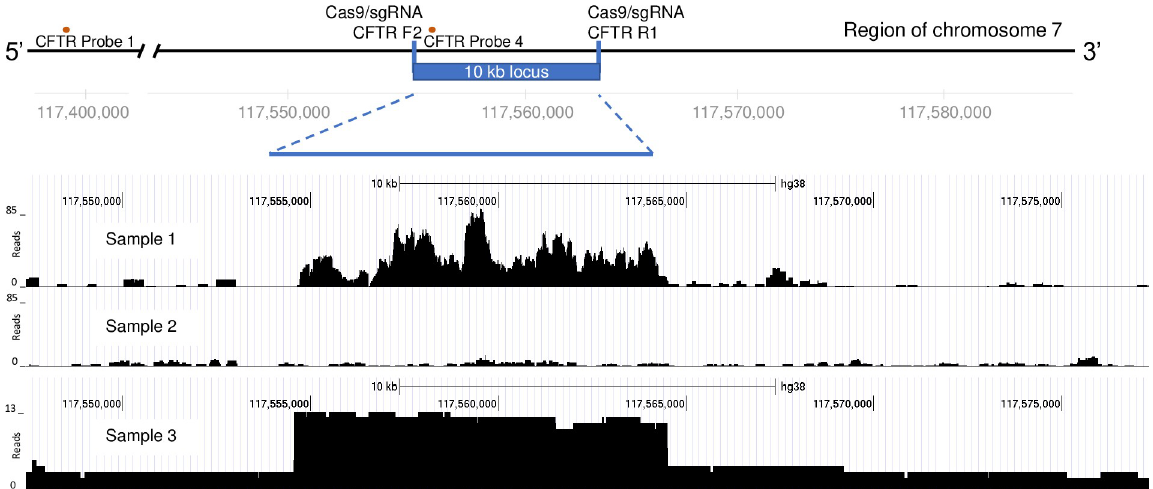
Fig 5. Illumina and Nanopore sequencing analyses demonstrate enrichment of the target human CFTR genomic protected region. NGS reads mapping to the CFTR region from an Illumina short read library prepared from Cas9/sgRNA and exonuclease treated human genomic DNA (Sample 1) and a control sample with no Cas9/sgRNA nor exonuclease treatment (Sample 2). Sample 3 is the plot of long-read Nanopore sequencing from a library prepared from Cas9/sgRNA and exonuclease treated human genomic